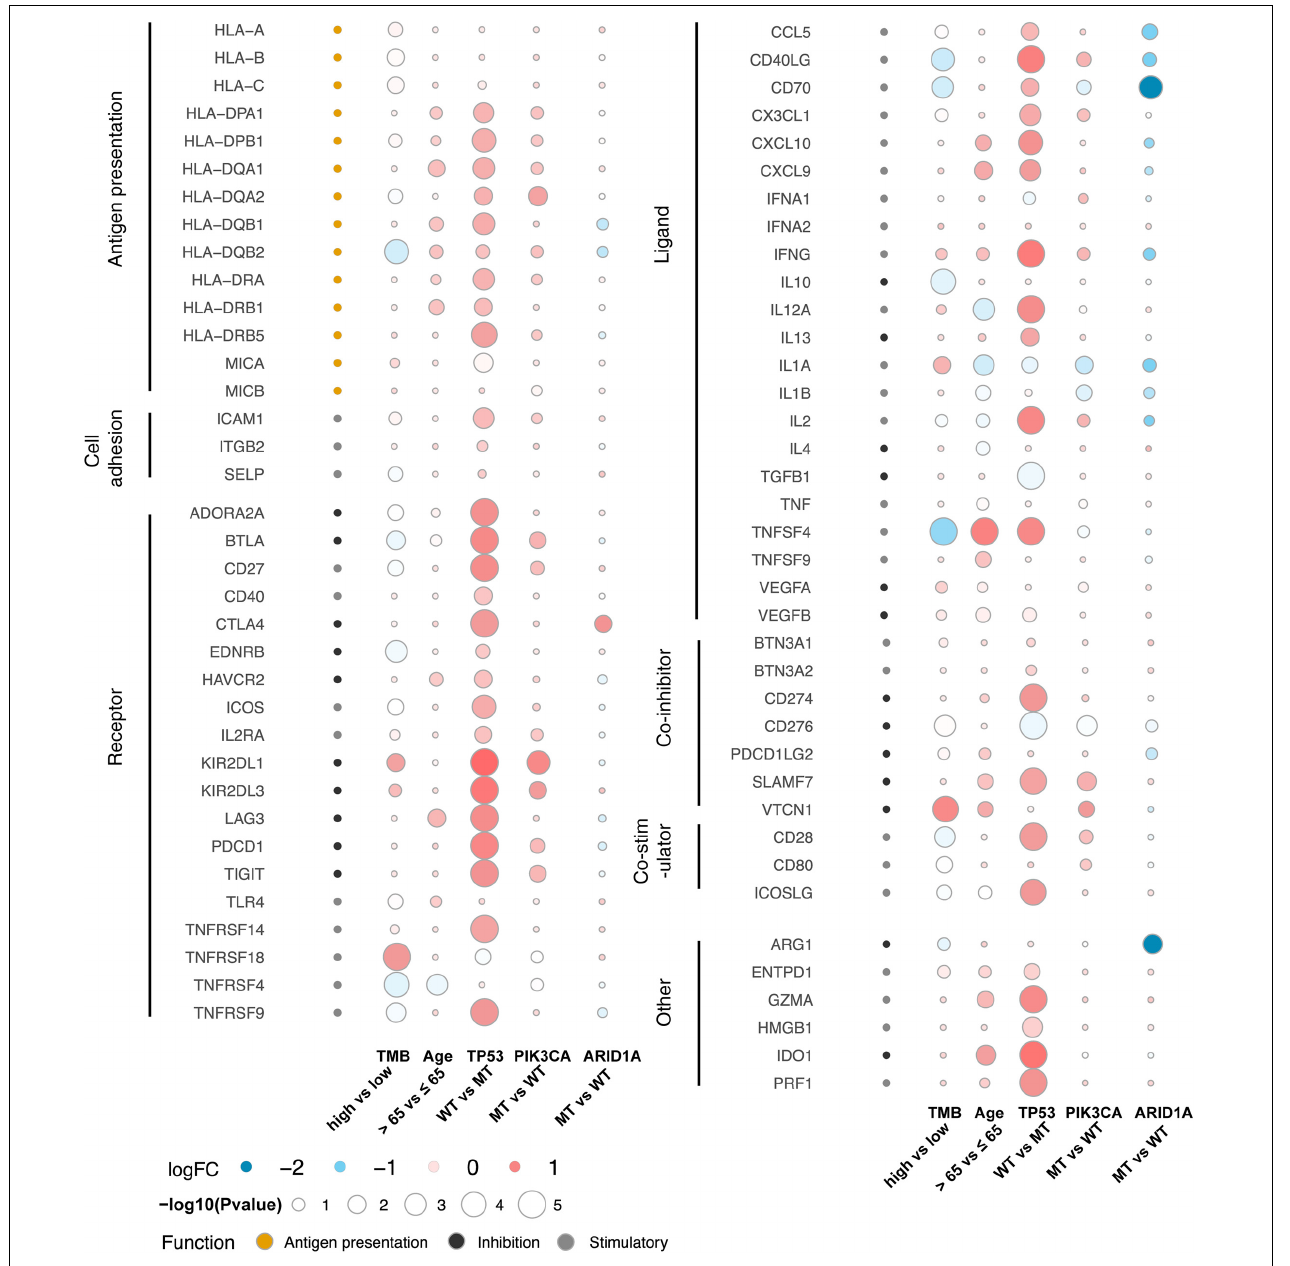
FIGURE 5 | Bubble plots showing the expression of immune-related genes and immune exhaustion biomarkers. The color of the circles in the first column represents the categories of the molecules according to their functions, in which orange represents antigen presentation, black represents inhibitory molecules, and gray represents stimulatory molecules. The color of the other circles indicates logFC, as shown in the legend, and the size is proportional to the statistical